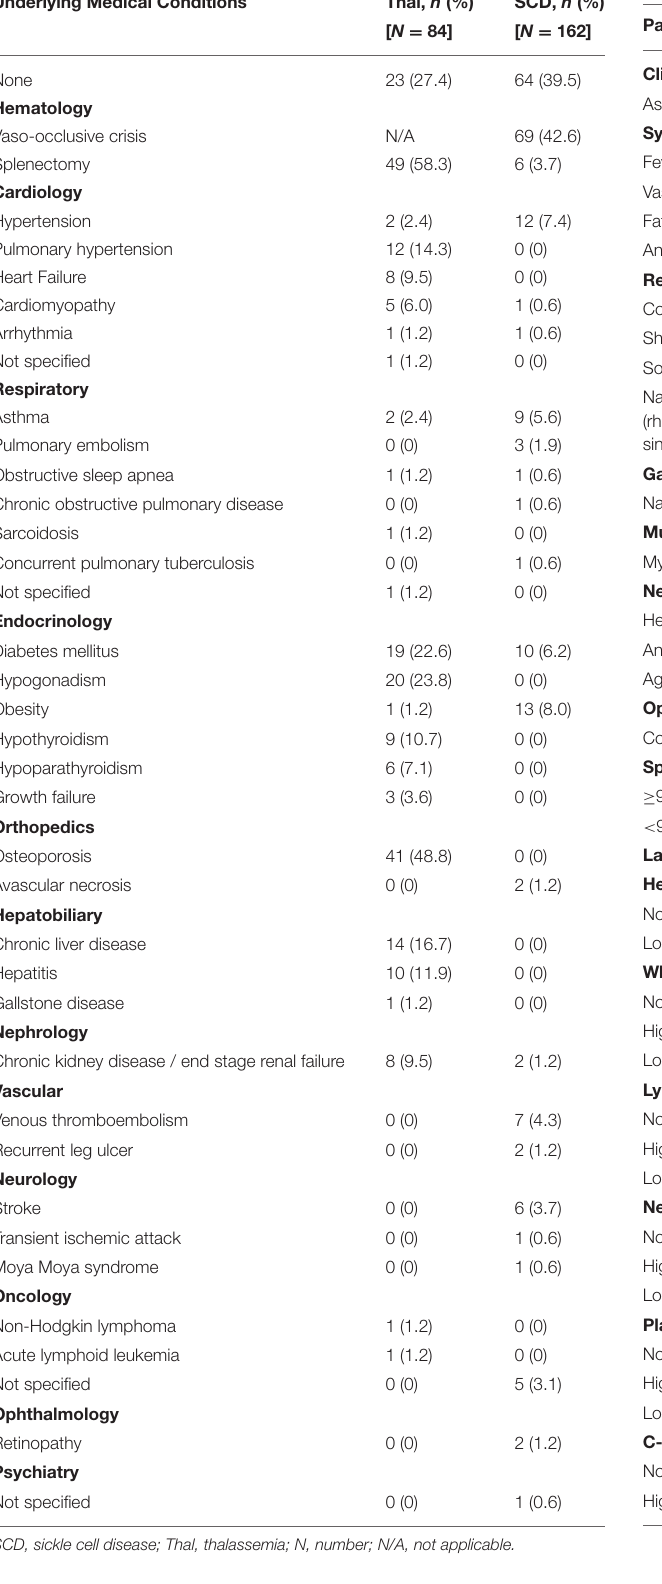
TABLE 2 | Underlying comorbidities of the study population. Underlying Medical Conditions